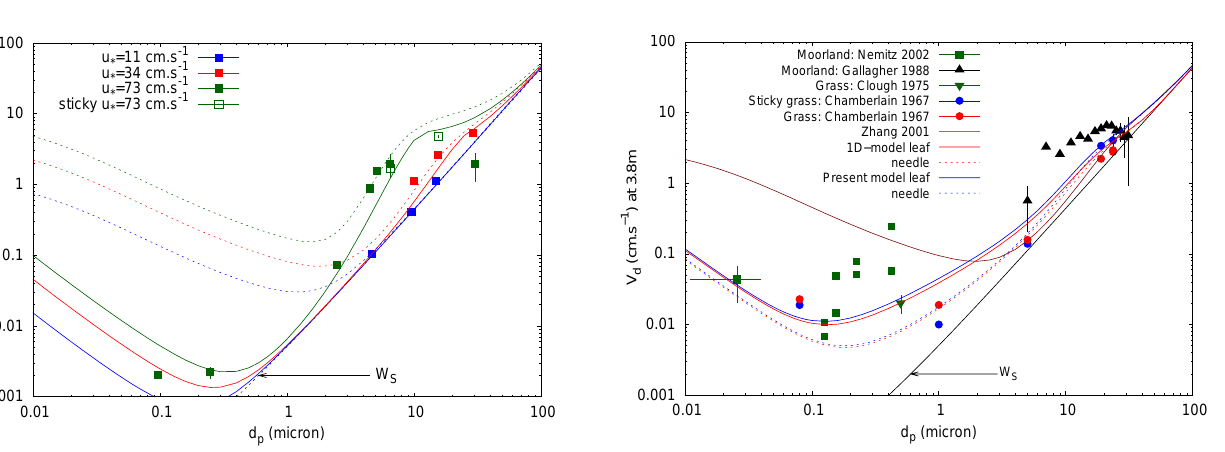
Fig. 3. Deposition on smooth soil, as measured through its mean and standard deviation by Sehmel (1973) and predicted by the present model and the model of Zhang et al. (2001), respectively in plain and dashed lines, for friction velocities of 11cms − 1 (blue), 34cms − 1 (red), 74cms − 1 (green). ( u ∗ ∈ [ 25 ; 55 cm s − 1 ] ). The atmosphere is assumed to be in near-neutral condition. A common height of 3.8 m is used to recalculate the deposition velocity (Eq. 10). Results are presented on Fig. 4.